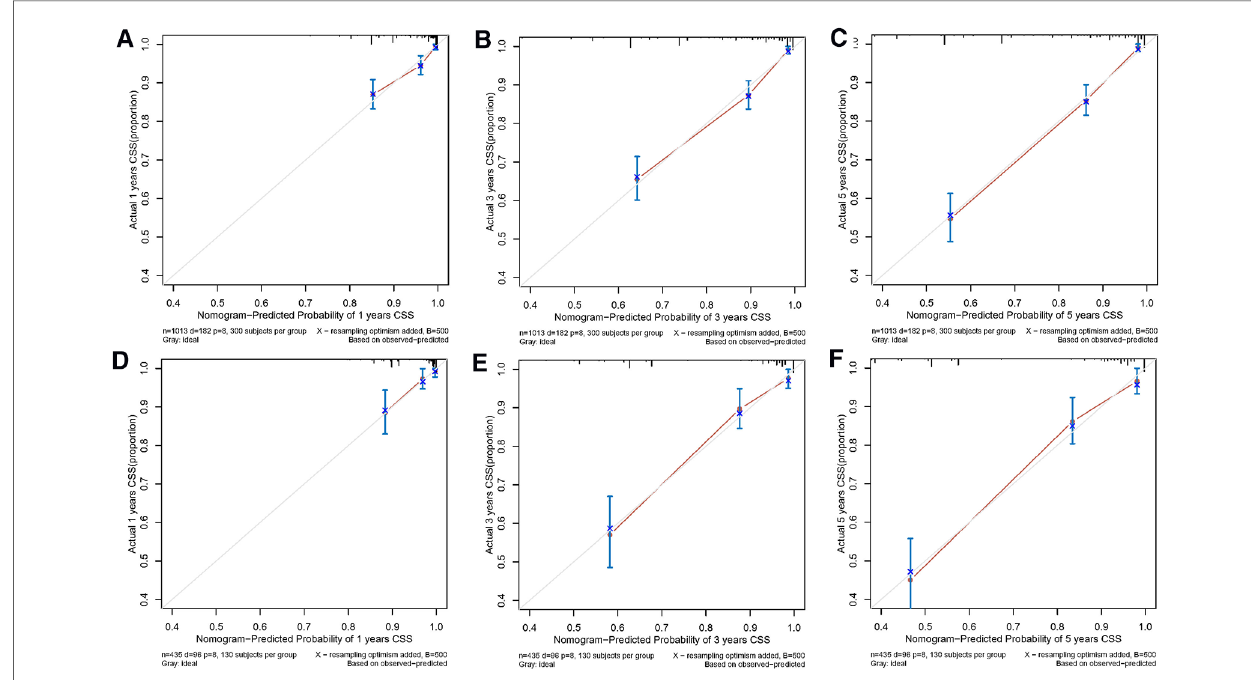
FIGURE 6 The calibration curves of the prognostic nomogram for predicting 1-year ( A ), 3-year ( B ), and 5-year ( C ) CCS in the training cohort. The alibration curves of the prognostic nomogram for predicting 1-year ( D ), 3-year ( E ), and 5-year ( F ) CSS in the validation cohort.